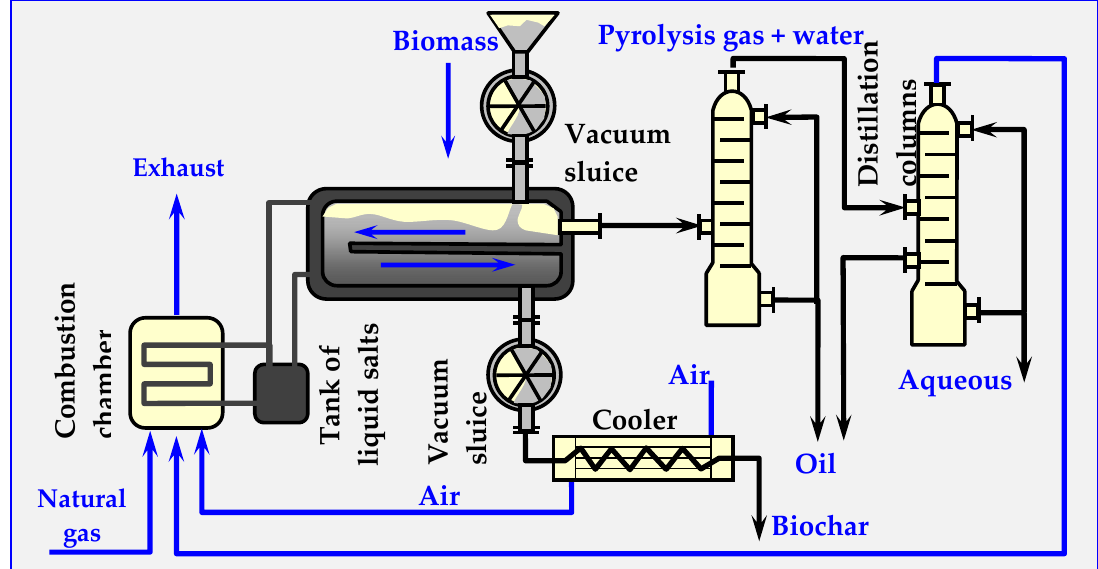
Figure 18. Technological diagram of the Pyrocycling™ process, in which the installations of vacuum pumps, transfer pumps and valves are omitted [17,129].